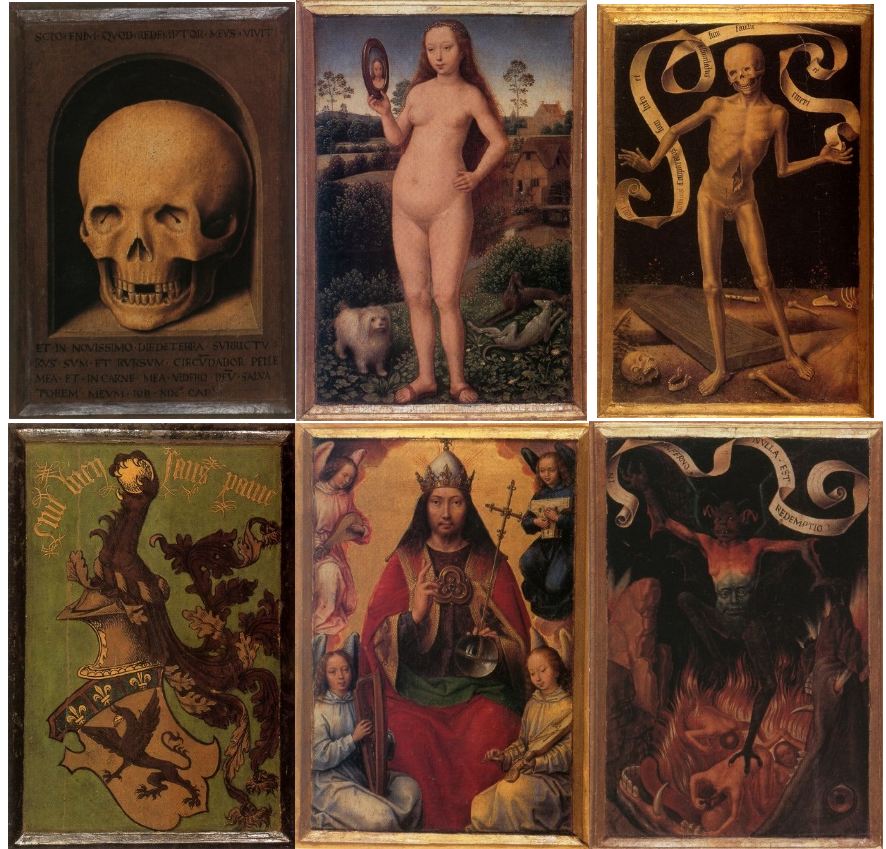
Figure 15. Hans Memling, Earthly Vanity and Divine Salvation , ca. 1480s, Strasbourg, Musée des Beaux-Arts.